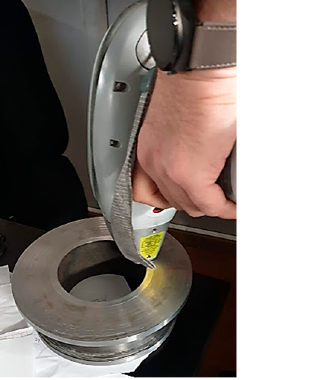
Figure 16. Comparison of results for filler wire. Chemical composition of the deposited material.